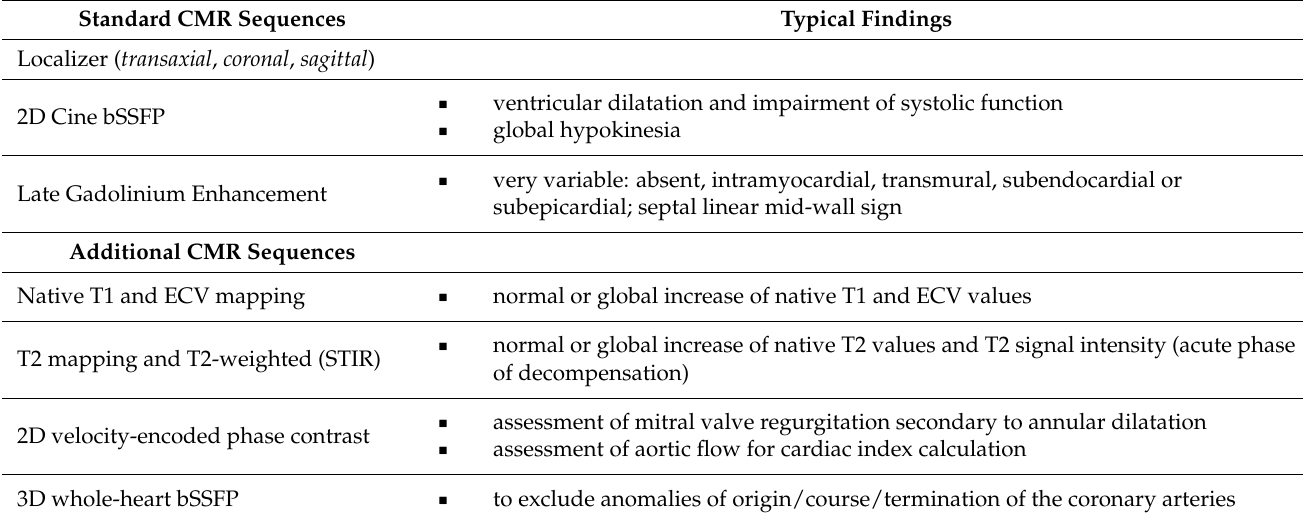
Table 1. Standard and additional CMR sequences for assessment of DCM in